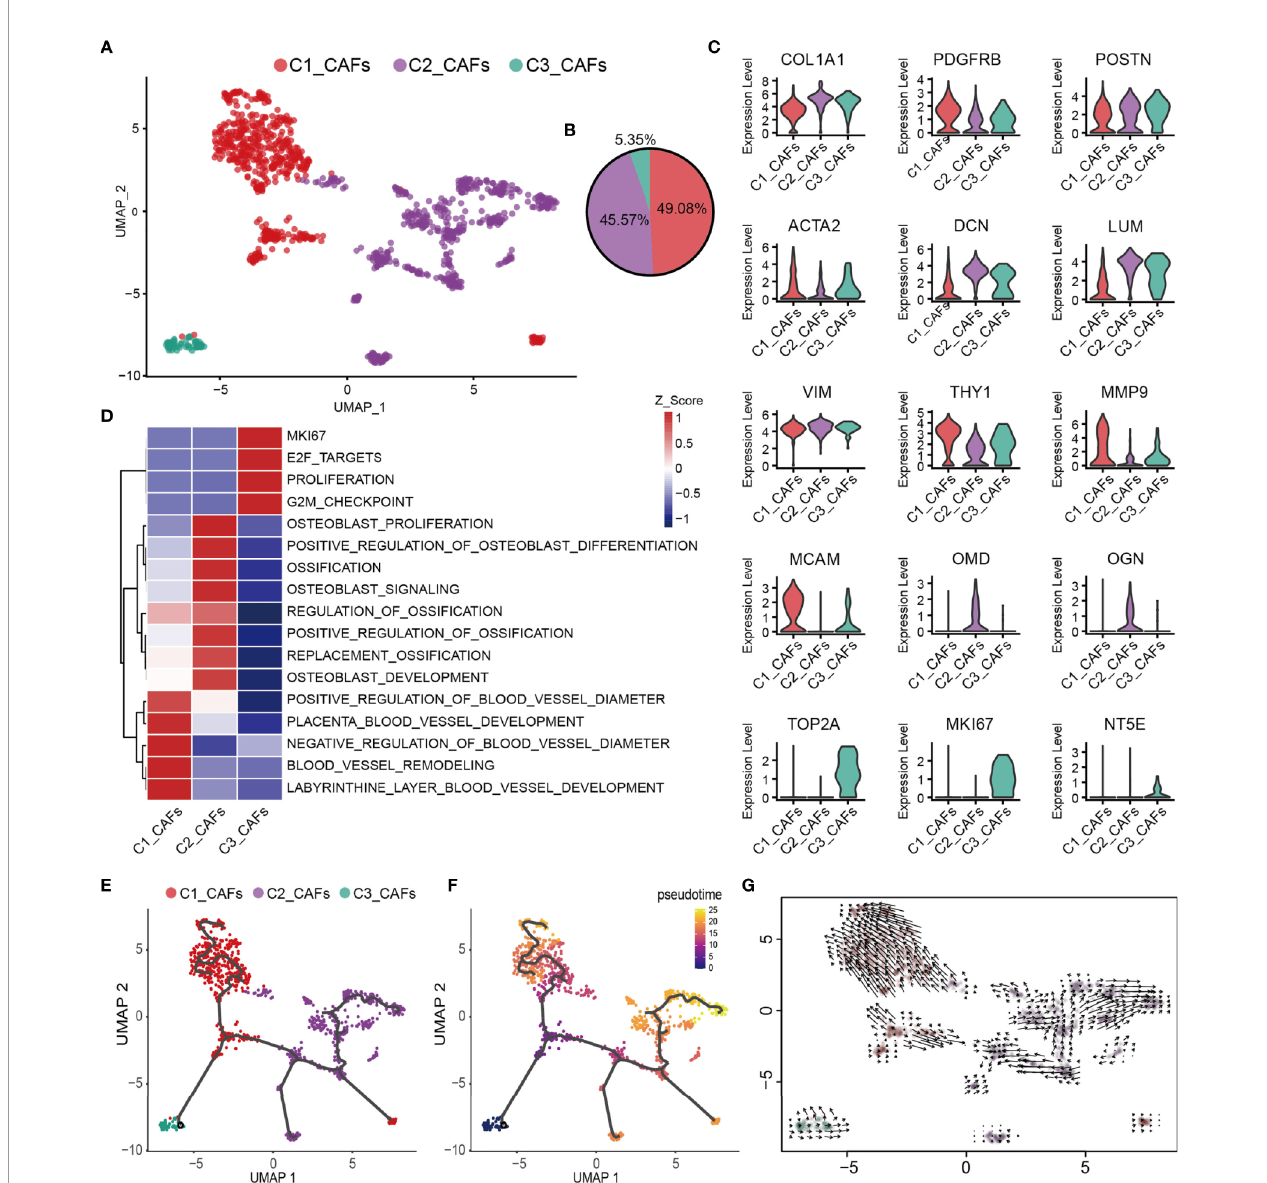
FIGURE 4 | Heterogeneity of CAF populations in human OS. (A) UMAP plot showing CAFs, with different cell types represented by the different colors. (B) Pie chart, showing the cell composition of CAFs; different cell types are represented by different colors. (C) Violin plots showing relevant marker genes of CAF subtypes. (D) GSVA, showing the function of C1_CAFs, C2_CAFs and C3_CAFs. (E, F) Differentiation and developmental trajectories of CAFs in OS; different colors represent the different cell subtypes. (G) RNA velocity fi eld projected onto the UMAP plot of the CAFs; arrows indicate the direction of differentiation and the average velocity. CAFs, cancer-associated fi broblasts; OS, osteosarcoma; UMAP, uniform manifold approximation and projection; GSVA, gene set variation